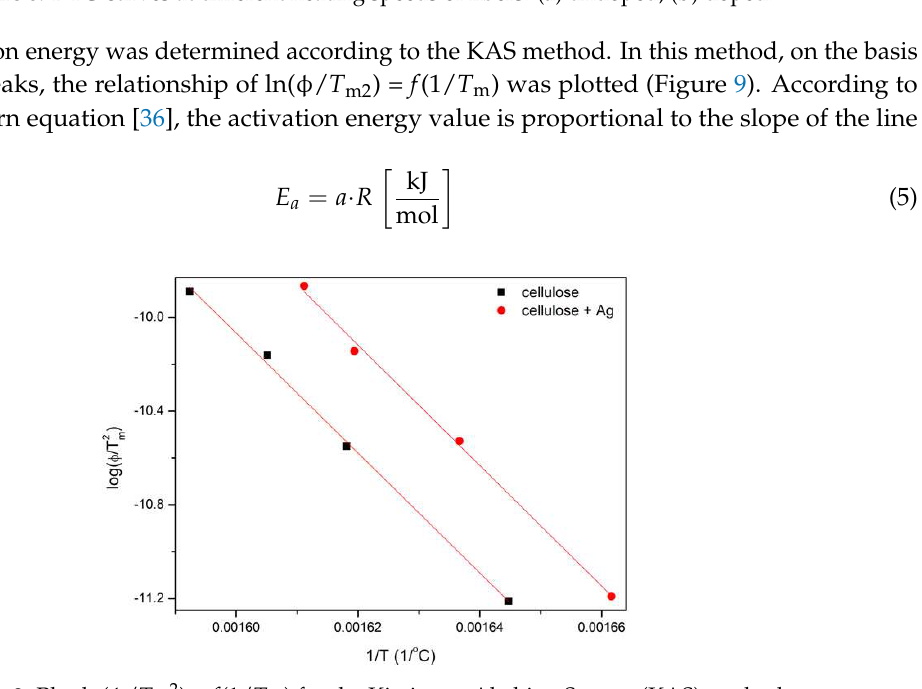
Figure 8. DTG curves at different heating speeds of fibers: ( a ) undoped; ( b ) doped.